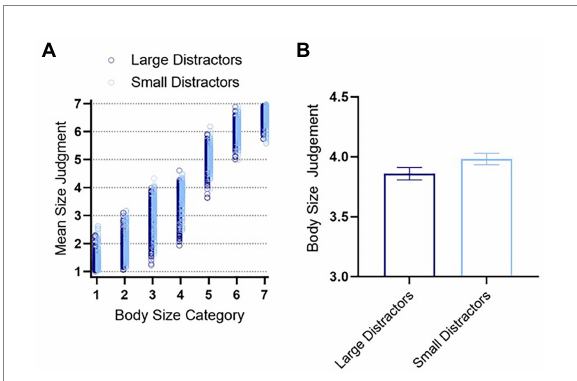
FIGURE 4 (A) Mean individual ratings for each body size category for all participants. (B) A summary of mean body size judgements for the small distractor and large distractor conditions. There was a significant difference between the conditions. Error bars represent ± 1 standard error of the mean. In (A) , the data for the small distractor condition has been nudged horizontally, for clarity. Created using GraphPad